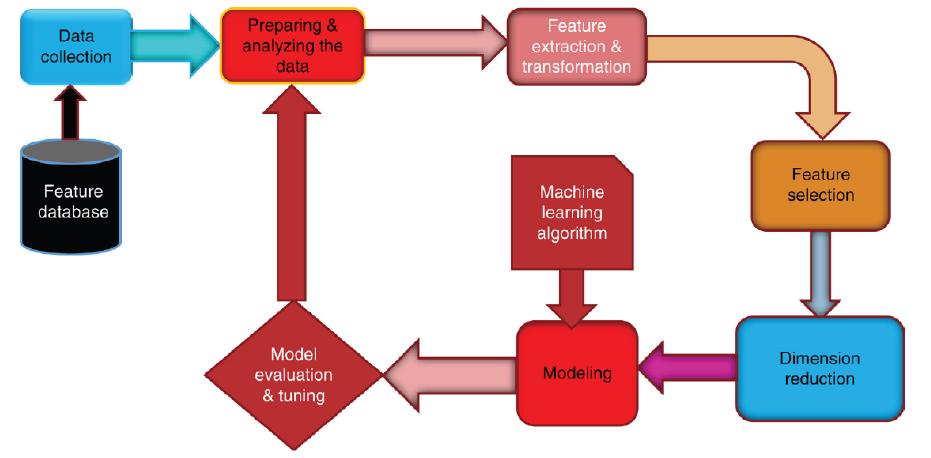
Figure 1. Supervised machine learning framework